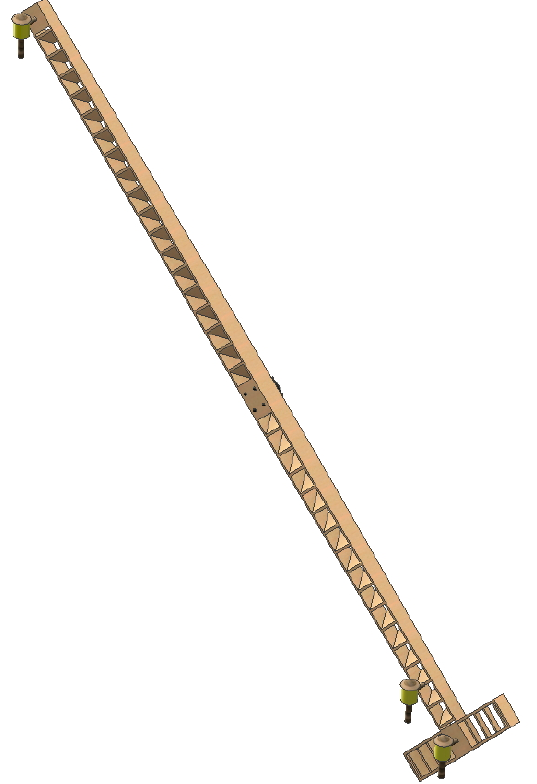
Figure 20. Indicator arrow.